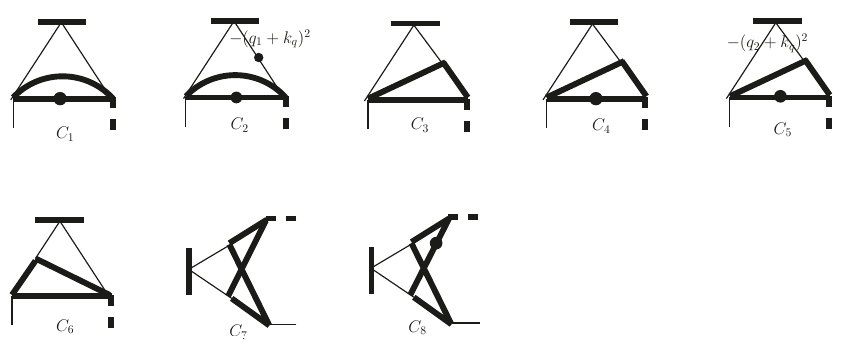
Figure 3 . The set of 8 master integrals that appear in sector II. Integrals ( C 1 : : : C 6 ) can be cast into canonical form, while integrals ( C 7 ; C 8 ) involve elliptic functions. The thin line denotes massless propagators and on-shell massless external particles; the thick line presents massive propagators and on-shell massive external particles; the dash line indicates o(cid:11)-shell external particles with momentum squared equal to 2 ss . The internal lines with a dot mean the power of the propagators being raised to